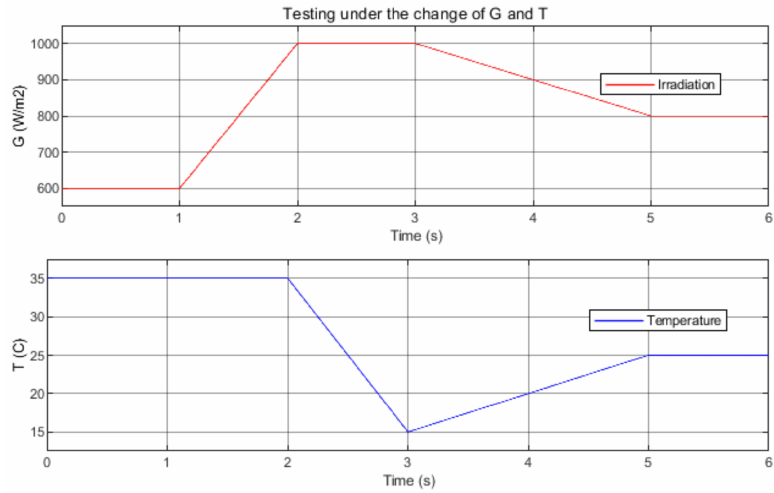
Figure 21. The change of weather